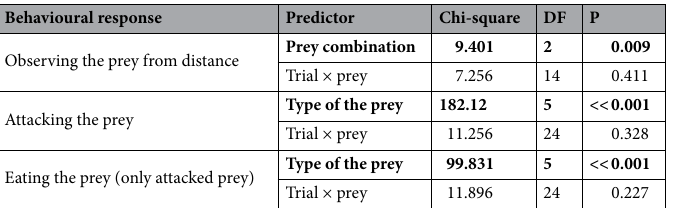
Behavioural response